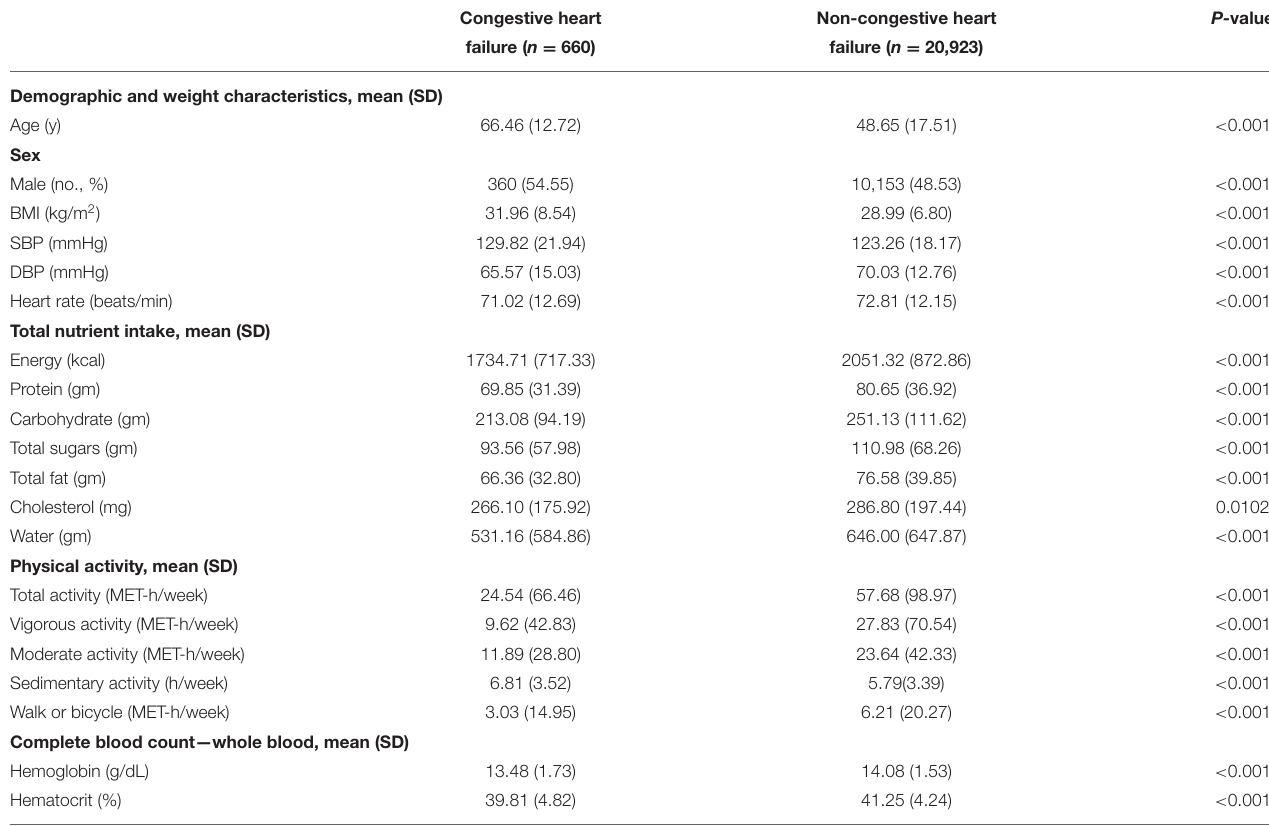
TABLE 1 | Characteristics of congestive heart failure group and non-congestive heart failure